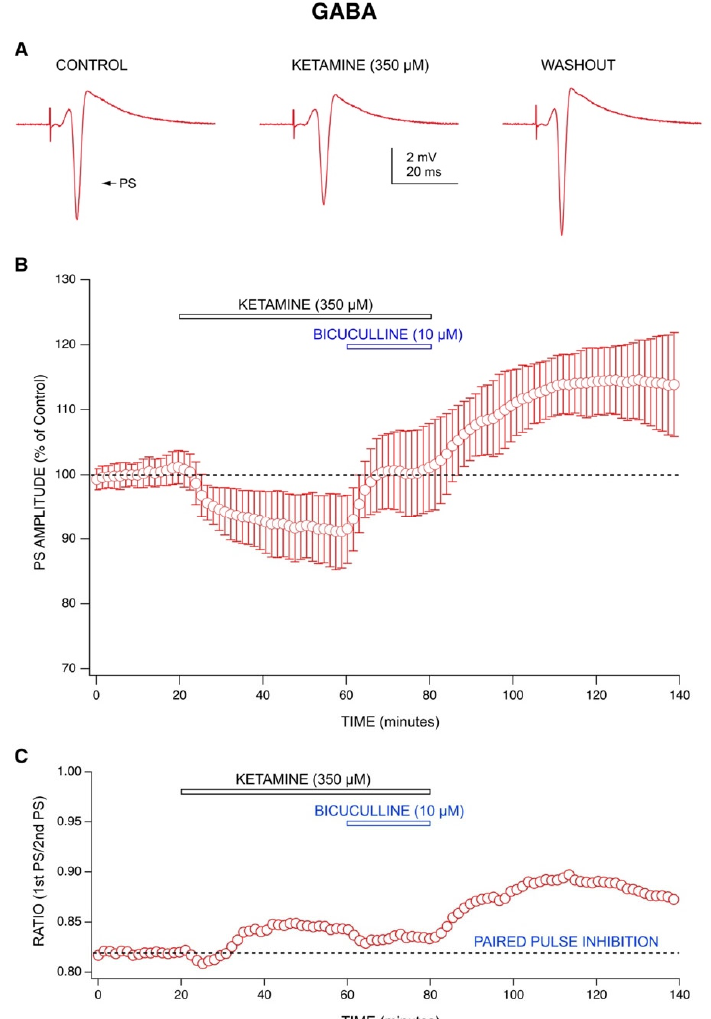
Figure 2. Evaluating the mechanisms behind ketamine’s effects: GABA receptors. ( A ) Representative recordings from one ketamine experiment (350 μ M) showing changes in PS amplitudes during application and washout. ( B ) Combined graph ( n = 5) shows 350 μ M ketamine produced a depression in PS amplitudes during application which was reversed by 10 μ M bicuculline. An increase in PS amplitudes was evident upon washout of ketamine and bicuculline. Each data point represents the mean ± standard deviation derived from a data set of five averaged experiments decimated from approximately 420 to 100 data points. ( C ) Paired ‐ pulse inhibition (PPI), calculated as a ratio of the amplitude of the first population spike (PS) divided by the second, was increased in the presence of 350 μ M ketamine ( n = 5). This effect was partially reversed by 10 μ M bicuculline. During washout of both ketamine and bicuculline, there was an increase in PPI.